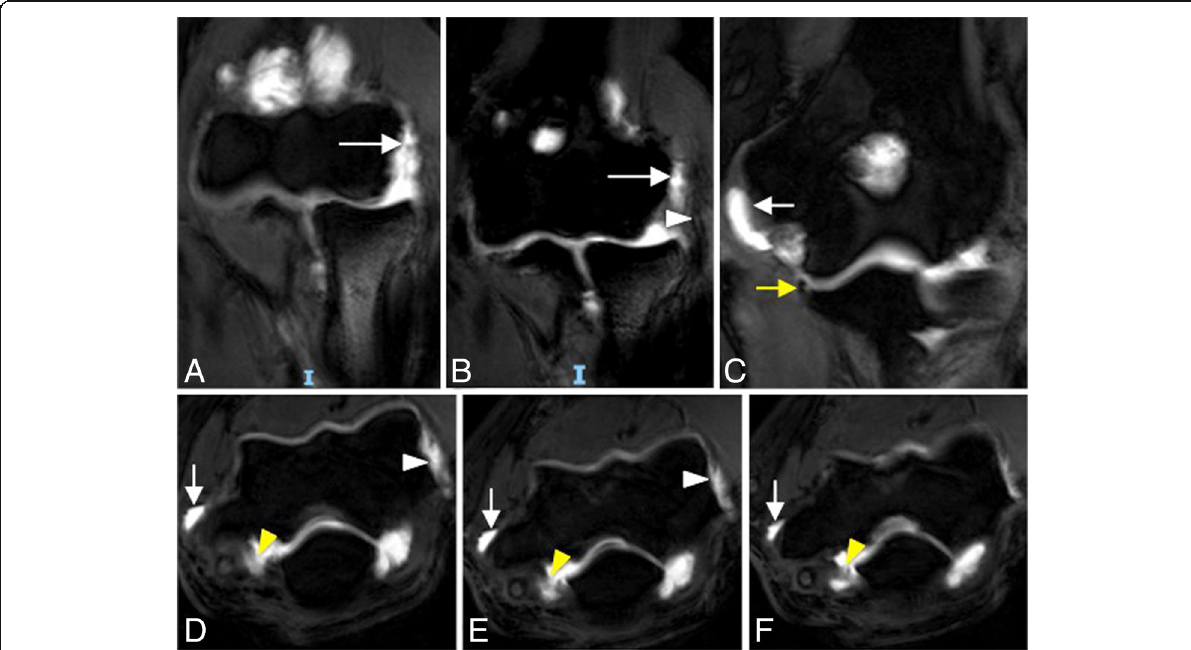
Fig. 28 Posterolateral rotatory instability, stage 3C. Consecutive coronal FS T1-weighted direct MR arthrographic images ( a – c ), and consecutive axial FS T1-weighted direct MR arthrographic images ( d – f ) demonstrating a full-thickness tear of the anterior bundle of the medial collateral ligament complex (yellow arrow), proximal full-thickness tear of the common flexor tendon (short white arrows), proximal full-thickness tear of the common extensor tendon (white arrowheads), proximal complete tear of the lateral ulnar collateral ligament and radial collateral ligament proper (long white arrows), and a complete tear of the posterior bundle of the medial collateral ligament complex (yellow